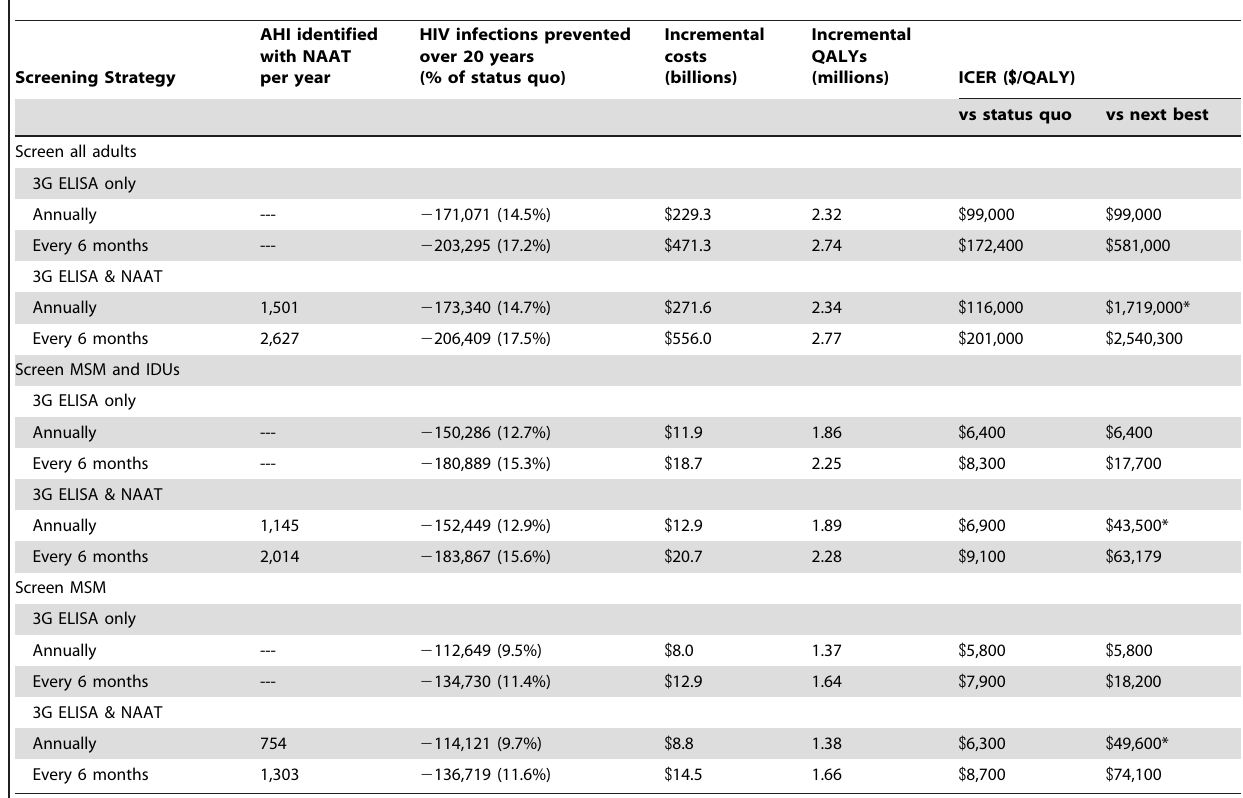
Table 3. Health and economic outcomes over 20 years with 3rd-generation ELISA.